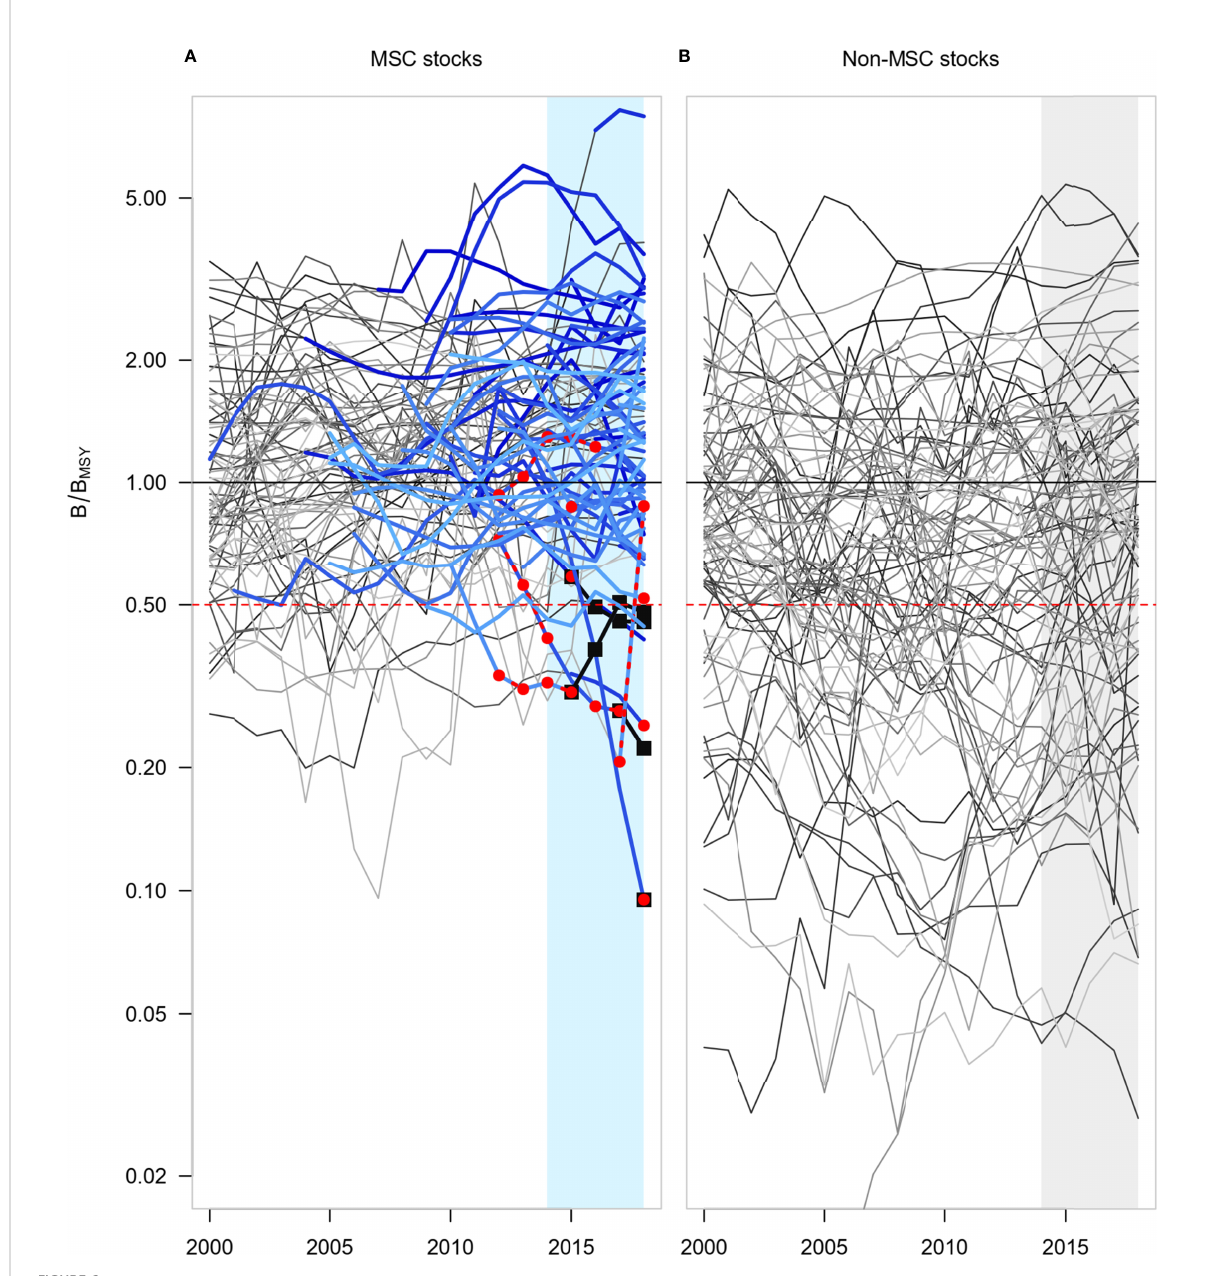
FIGURE 6 Time series of relative biomass ( B / B MSY ) of (A) MSC stocks (n = 81) and (B) non-MSC stocks (n = 93) for years 2000-2018. B / B MSY is shown on log scale with truncated axis at lowest value. Lines show individual stocks. For MSC stocks, grey portions of lines represent pre-certi fi cation years and blue portions represent post-certi fi cation years. Red points indicate years in which nine MSC stocks were under suspension related to MSC Principles 1 or 3. Black squares indicate years in which and thereafter four of these MSC stocks withdrew from the program while under suspension. Target ( B MSY at 1) and limit ( B lim at 0.5) reference point thresholds are shown for comparison. Blue and grey shading over years 2014-2018 highlights the focal period shown in Figure